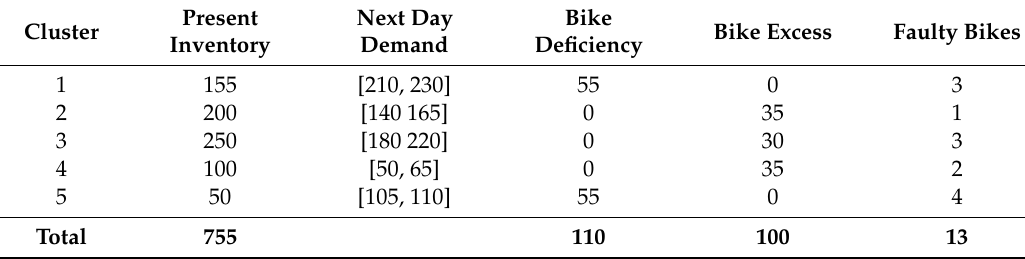
Table 10. The number of present usable and faulty bikes, and the next day demand at each cluster.